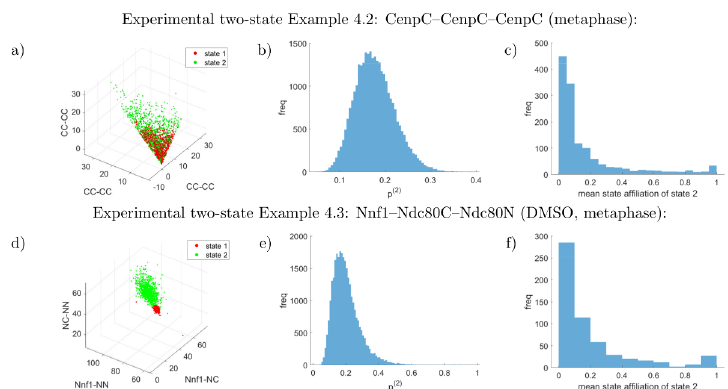
Fig 13. Two-state examples for experimental datasets, Examples 4.2, 4.3. Marginal lengths (in nm) in first column (a,d), the majority state is depicted in red, the minority state in green. See supplement Uninformative priors in S1 Text for the joint prior on the lengths. Marginal state proportions of the minority state are depicted in the second column (b,e). The prior on each state proportion is flat in [0, 1]. The third column (c) shows the mean state affiliations.